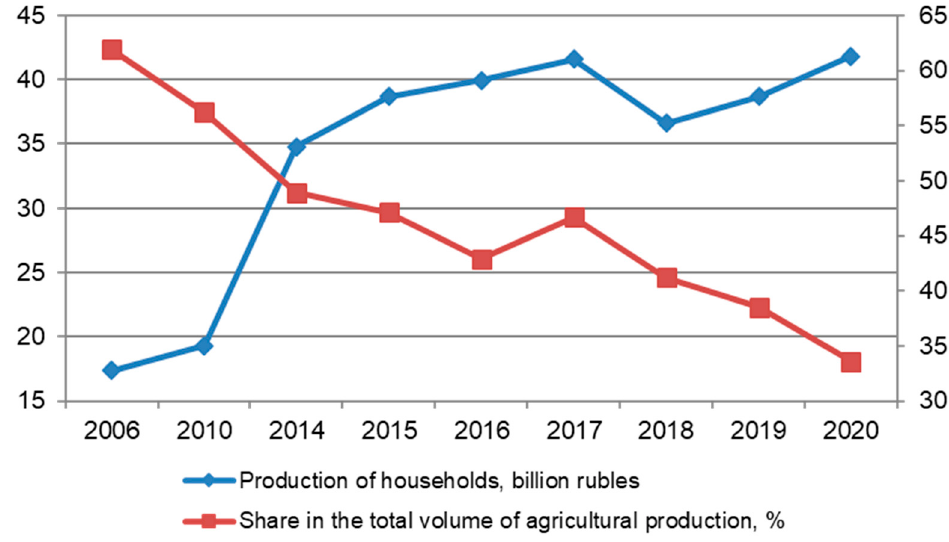
Figure 2. Agricultural products in the households of the Samara region population. Table 1. Parameters of regression equation